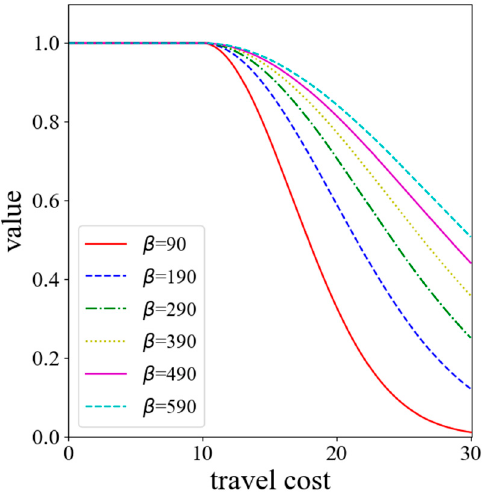
Figure 6. The revised Gaussian function with different impedance coefficients ( β ).